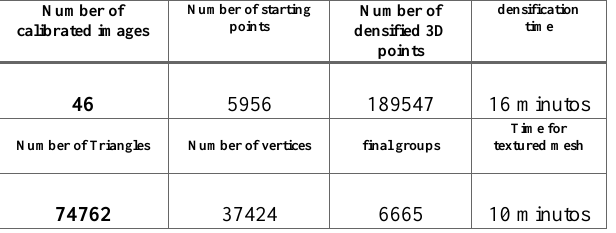
Table 2. Petroglyph quantitative results, videogrammetric method.